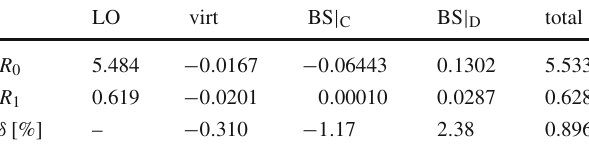
Table 5 Radiative corrections based on their origin and their respective contributions to the ratio (124) and to the total correction δ to the decay rate. The first column shows R at LO. The subscripts ‘C’ and ‘D’ at the BS correction correspond to the (IR-)convergent and divergent parts, respectively. The values of R i are to be multiplied by 10 −